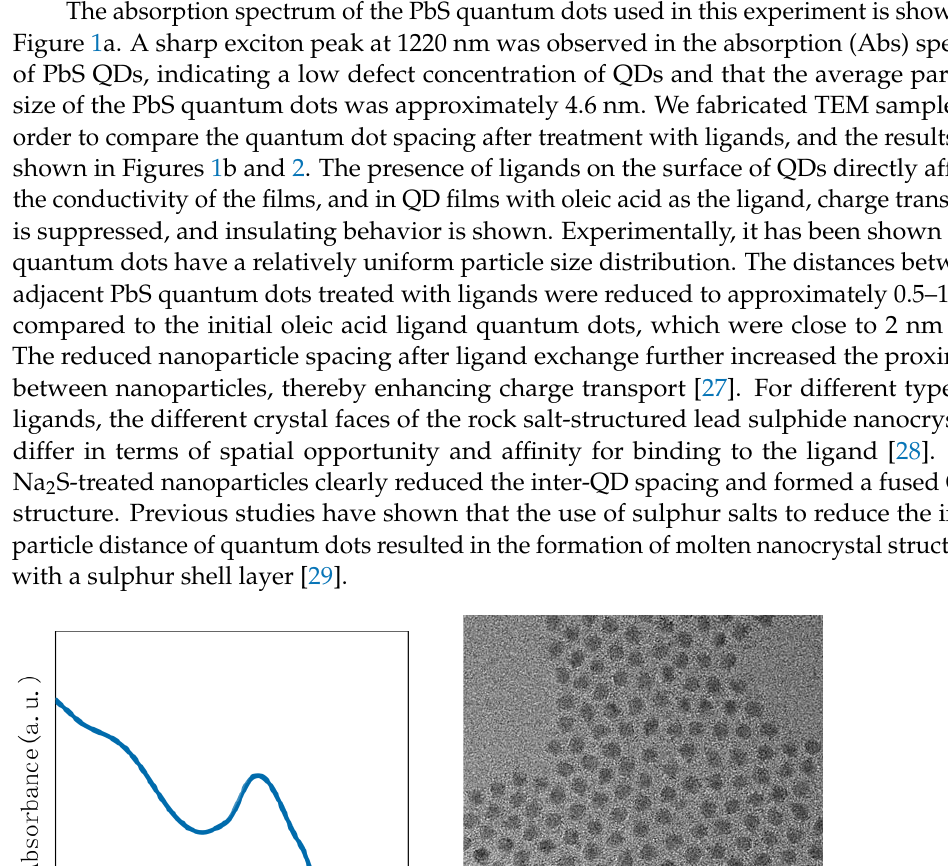
( d ) Figure 2. TEM images of the PbS QD films capped with ( a ) EDT, ( b ) TBAI, ( c ) CTAB, and ( d ) Na 2 S. Scanning electron microscopy (SEM) images of the PbS QD films (on silicon) after ligand exchange are shown in Figure 3a – d. From the images, ligand-treated quantum dot films can be found to exhibit defects, such as cracks or holes, which are detrimental to the transport of electrons in the films and may interfere with the performance of the optoelec- tronic devices, and are reduced by multiple spin coating [30]. There are considerable dif- ferences between the Na 2 S-treated quantum dot films and the other samples, exhibiting outstanding morphological characteristics. Further results using FIB-TEM, as shown in Figure 4a,b, indicate that the nanoparticles treated with Na 2 S are tightly aligned, and the adjacent quantum dots are connected to each other. There are clear lattice stripes and no obvious lattice defects in the quantum dots, which also demonstrates the high crystal qual- ity of the synthesized PbS quantum dots.